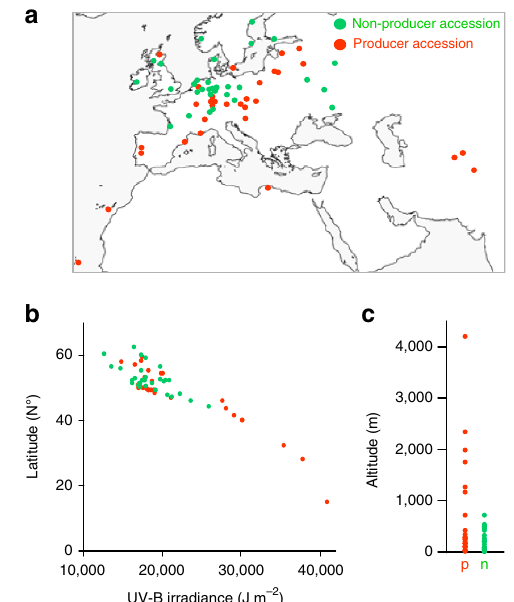
Figure 3 | Geographical distribution of A. thaliana accessions used in this study. ( a ) Geographical distribution of producers (orange) and non-producers (green) in the world scale map. A total of 63 A. thaliana ecotypes are mapped. ( b ) Plots of producers and non-producers (by latitude (N (cid:2) ) and UV-B irradiation (Jm (cid:2) 2 ) averaged of daily UV-B irradiance during 1985 and 2005 estimated from satellite data (Soda (http://www.soda-is.com/eng/index.html)). r 2 ¼ 0.8624 (producers) and 0.4476 (non-producers). ( c ) Plots of producers and non-producers by altitude (m) estimated by Shuttle Radar Topography Mission (http:// www2.jpl.nasa.gov/srtm/). Map by FreeVectorMaps.com. Green and orange indicate non-producing and producing accessions,